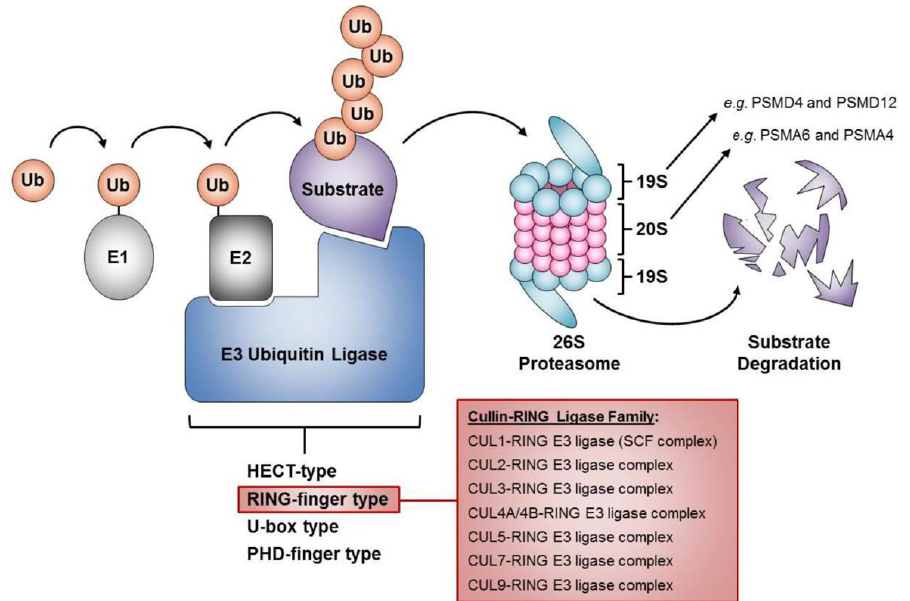
Figure 1. The Components of the ubiquitin – proteasome system. Substrates intended for degradation by the 26S proteasome are poly-ubiquitinated through the concerted activities of an E1 ubiquitin-activating enzyme (E1), an E2 ubiquitin-conjugating enzyme (E2), and an E3 ubiquitin-protein ligase (E3). The four major E3 ubiquitin ligases families are listed and include the HECT, RING-finger, U-box, and PHD-finger families. Additionally, the seven RING-finger type Cullin-based ligases are listed (red box), which includes the prototypic CUL1-based SCF complex. Ub, Ubiquitin; PSMD4, Proteasome 26S Subunit Non-ATPase 4; PSMD12, Proteasome 26S Subunit Non-ATPase 12; PSMA6, Proteasome Subunit Alpha 6; and PSMA4, Proteasome Subunit Alpha 4.